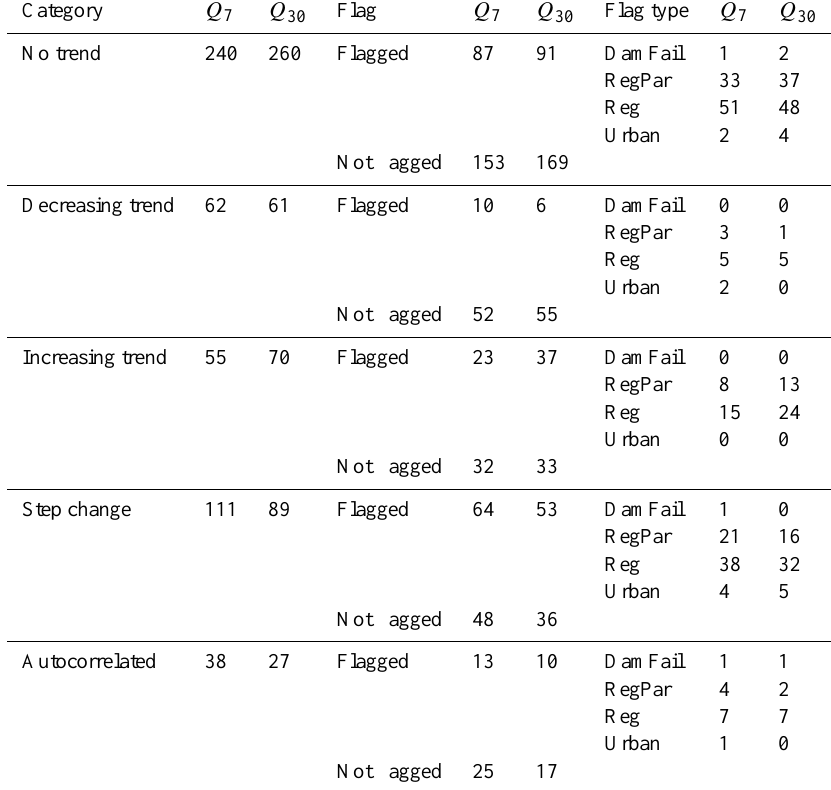
Table 1. Comparison of the number of streamflow gauging sites in each category of the decomposition algorithm and their USGS flags for Q7. DamFail: dam failure; RegPar: partially regulated; Reg: regulated; Urban: affected by